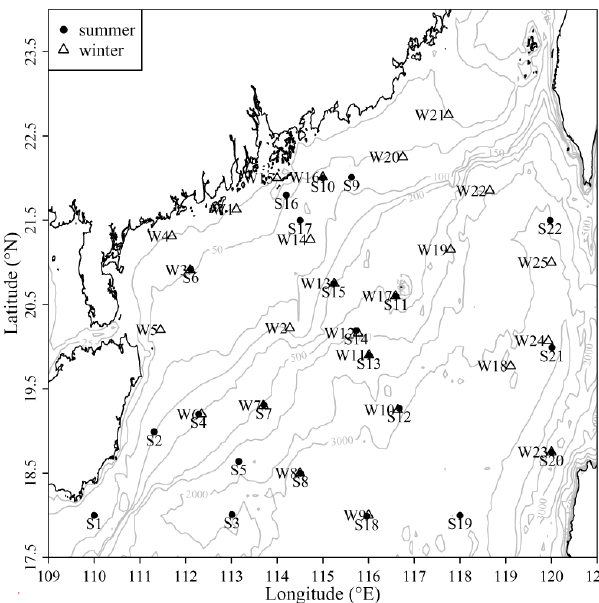
Fig. 1. Experimental